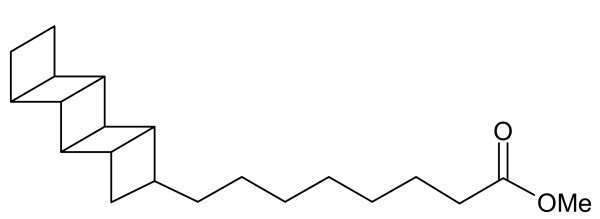
Nature is known to synthesize "fancy" compounds. A natural occurring ladderane produced by the anammox bacterium "Candidatus Brocadia anammoxidans"